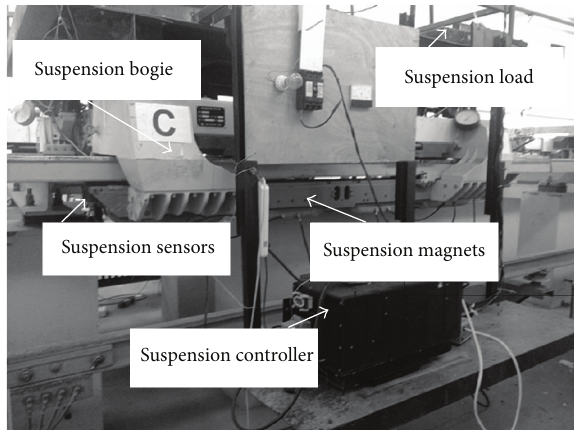
Figure 5: CMS04 maglev control experiment platform based on magnetic flux feedback.